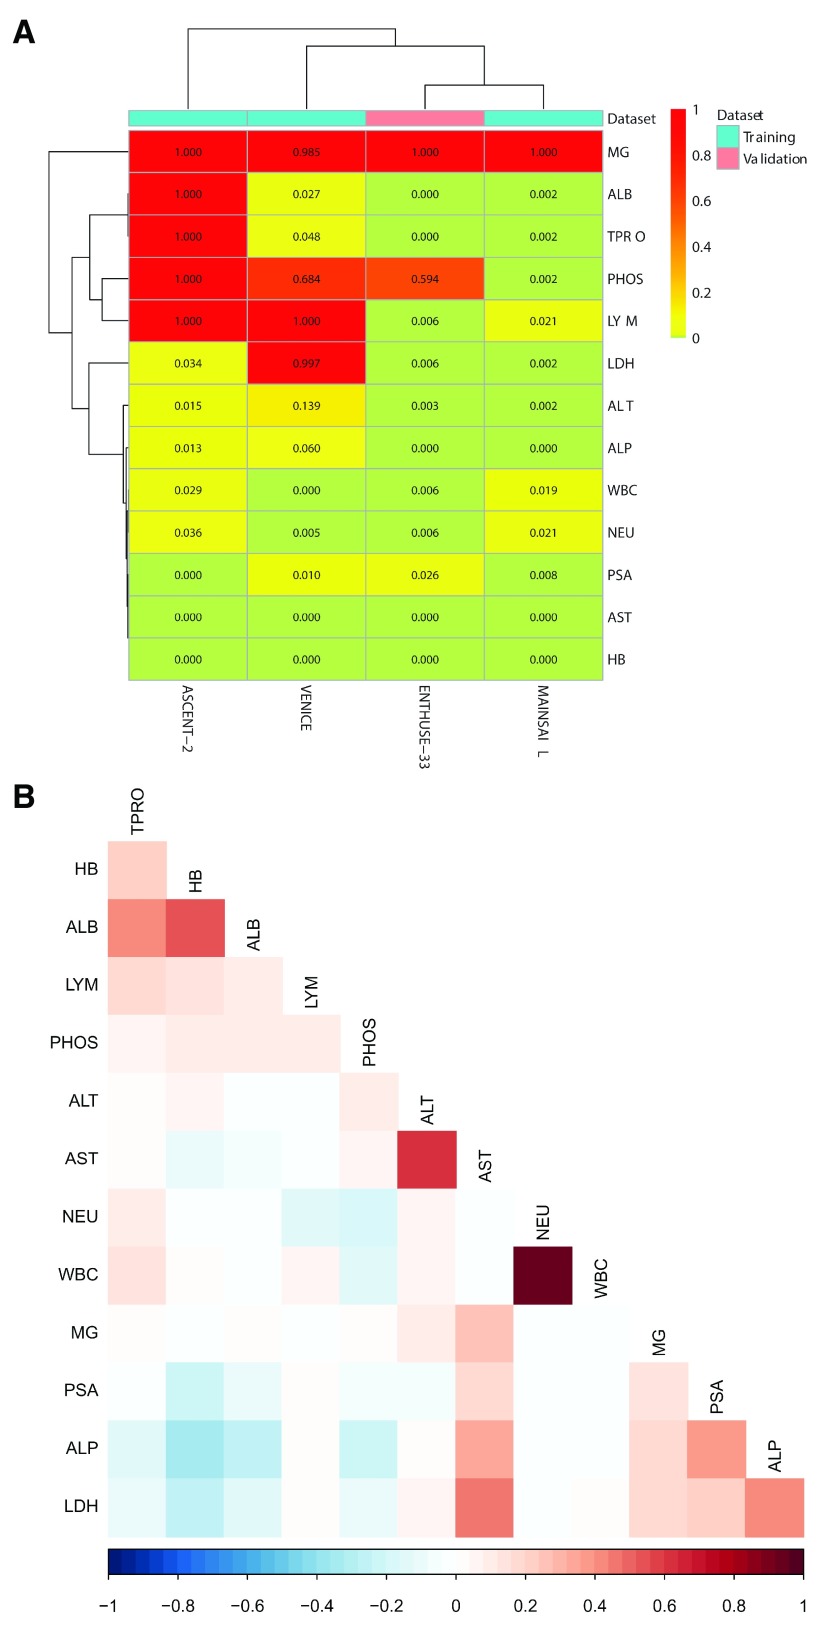
Missing values and correlations in the training data.(
A) Proportions of missing values for the 13 lab tests selected on the basis of consultation with oncologists. The proportion of missing values is shown separately for each clinical trial dataset (columns), with red indicating large proportions of missing values. (
B) Pearson correlation between the different features across all studies. The darker the color, the higher the absolute value of correlation.